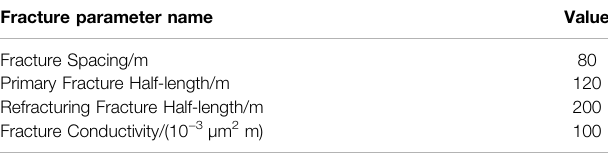
TABLE 4 | Increase the original fracture length Fracture parameter table.